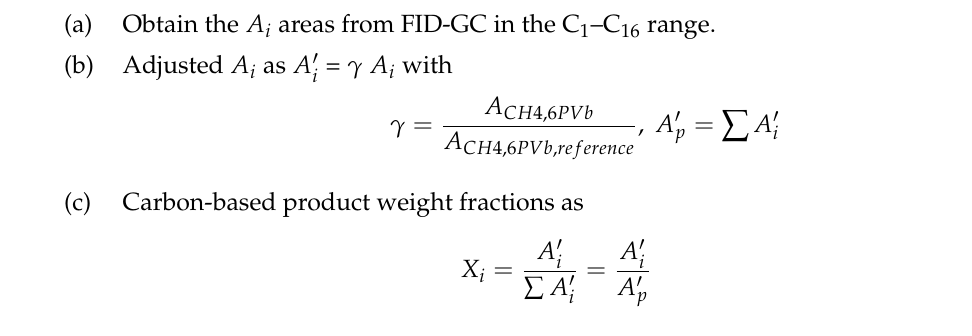
Figure A3. Hc2 % Mass Balances for 15 Catalytic Cracking Runs of 1,3,5-TIPB, Following Reactor Evacuation, with Vacuum Box and Reactor being at Equilibrium, Using the Method Described in Appendix A: Condition 3, Standard Deviation: ±7.3%.